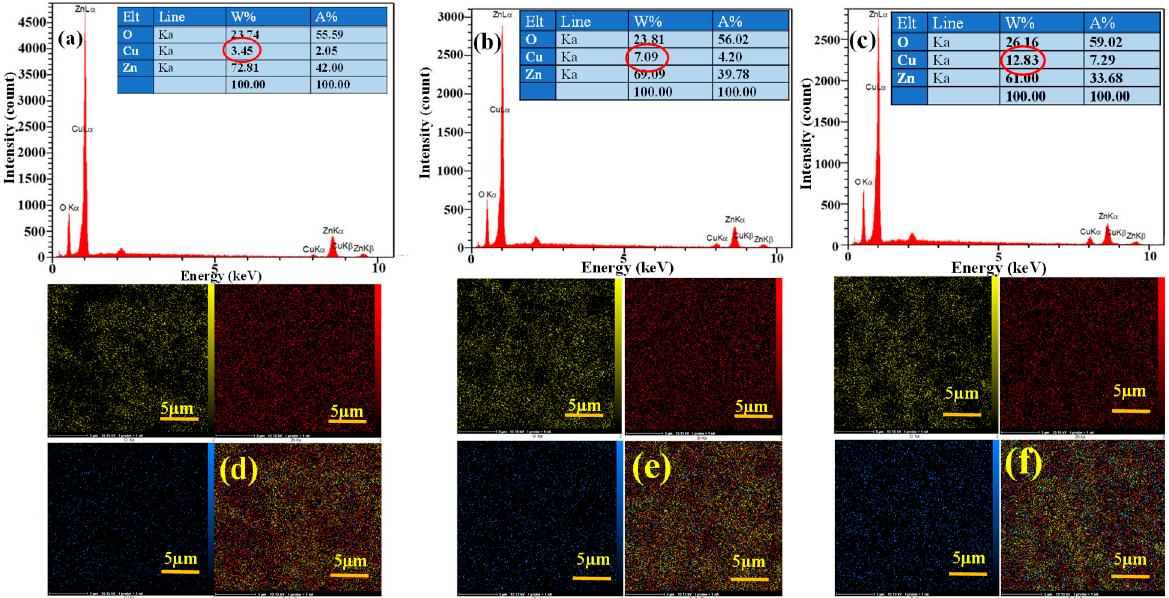
Figure 6. EDX spectra of ZnO-CuO nanocomposite for ( a ) ZC5, ( b ) ZC10, and ( c ) ZC20, and mapping analysis for ( d ) ZC5, ( e ) ZC10, and ( f ) ZC20.